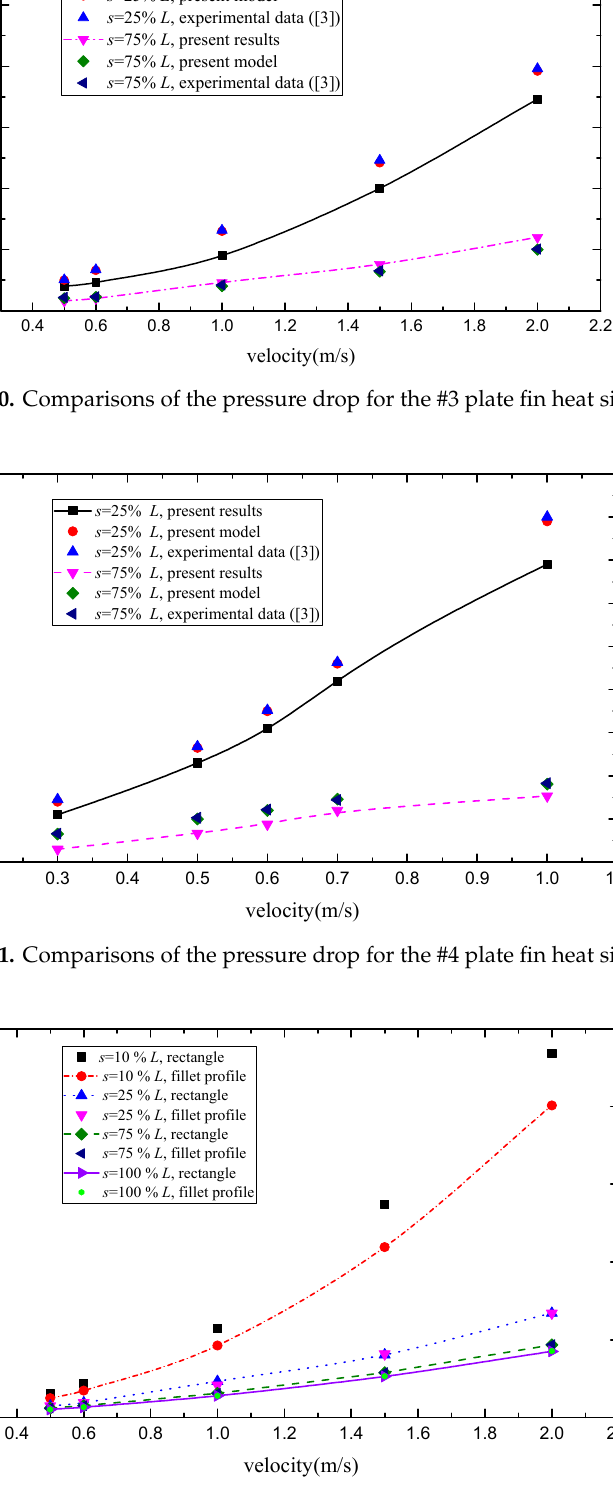
Figure 12. Comparison of the pressure drop of plate fin heat sink with elliptic bottom profiles and without elliptic bottom profiles on the bottom of the channels. Figure 13 shows the comparison of the velocity distributions at the plane of half fin height Z = 13.25 mm for the plate fin heat sink without elliptic bottom profiles and that with elliptic bottom profiles for s = 10% L . The results demonstrate a striking trend: the mean velocity is smaller for the channels with elliptic bottom profiles as compared to channels without elliptic bottom profiles, regardless of the channel width. The distribution of velocity for the plate fin heat sink with elliptic bottom profiles is more uniform than that without elliptic bottom profiles. There are three peak velocities at the condition of v = 0.5 m/s for the plate fin heat sink without elliptic bottom profiles. The change from a rectangular channel to a fillet profile channel reduces the friction and the contact area between the fluid and the fin due to the addition of the fillet profile, which will lead to a smaller pressure drop.